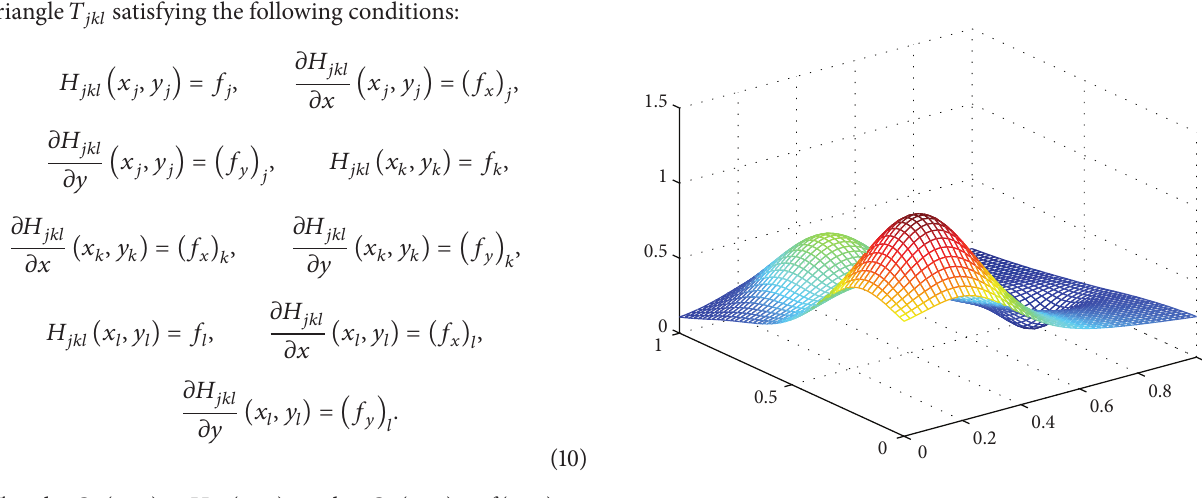
Figure 6: The graph of Franke